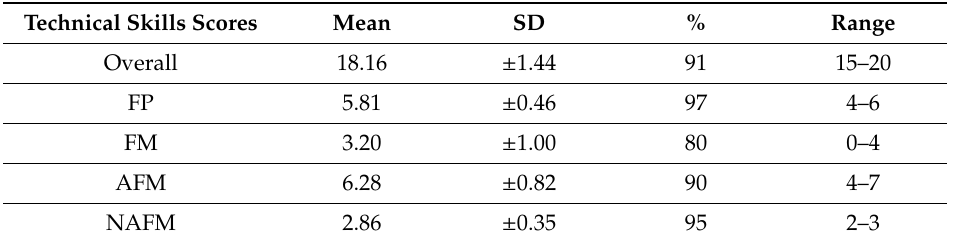
Table 1. Technical Skills Scores.